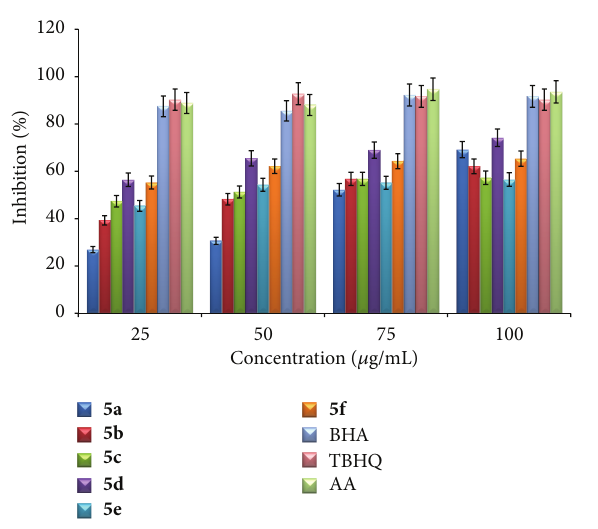
Figure 4: Ferric (Fe 3+ ) ions reducing capacity of the compounds ( 5a–f ).